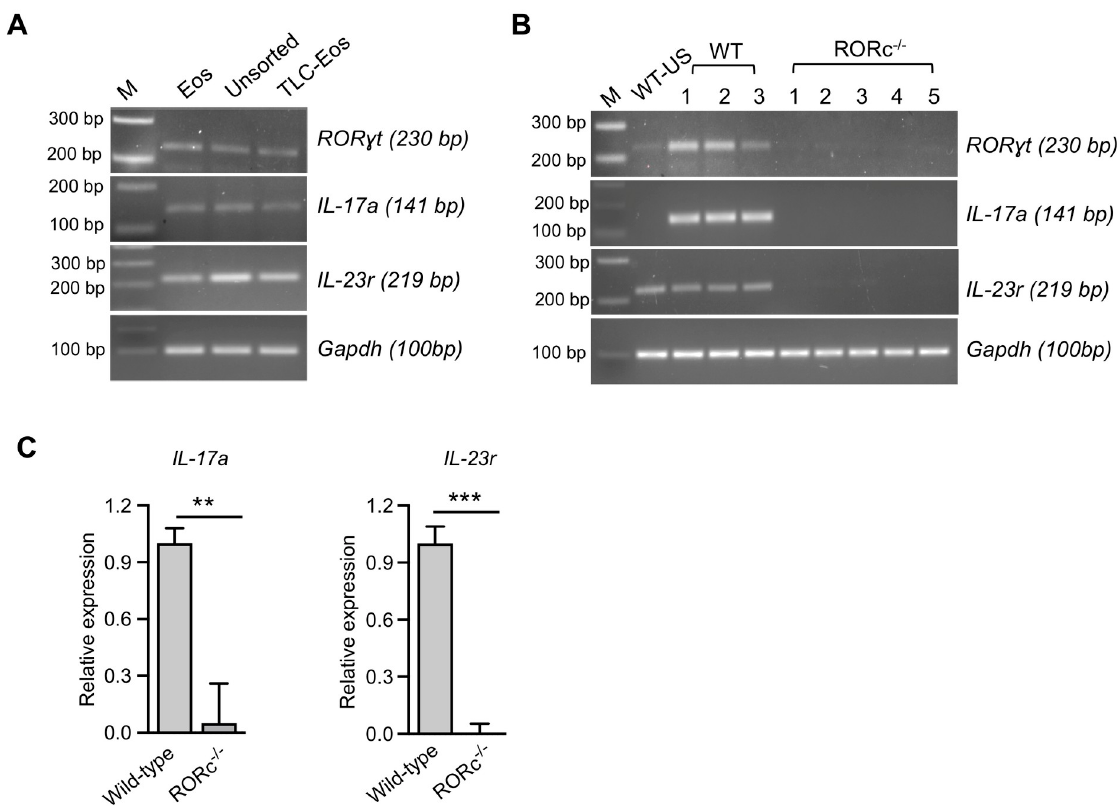
Fig 5. ROR γ t, IL-17 and IL-23r gene expression in lung eosinophils from wild-type and RORc -/- mice with allergic aspergillosis. (A) Allergic aspergillosis was induced in C57BL/6 mice as in Fig 1A, following which lungs were harvested and single cell preparations were made. The total lung cells (TLC) were separated into two populations by flow-sorting: eosinophils (Eos) and the rest of the lung cells (TLC— Eos). Unsorted TLC from a lung of allergic mice was also collected. ROR γ t , IL-17a , IL-23r mRNA in the three cell populations was analyzed by RT-PCR. Gapdh served as a loading control. These results are representative of two independent experiments with n = 7–8 mice per experiment. The indicated DNA ladders served as base pair (bp) markers (M). (B) Allergic aspergillosis was induced in wild-type (WT, n = 3) and RORc -/- mice (n = 5), following which mRNA was isolated from harvested lungs and analyzed by RT-PCR for ROR γ t , IL-17a , IL-23r and Gapdh . DNA markers are as in Fig 5A. Wild-type unstimulated (WT-US) refers to results obtained using lung mRNA from a na ï ve (non- allergic) mouse. The remaining lanes show results from mRNA isolated from the lungs of individual WT and RORc -/- mice with allergic aspergillosis. (C) Real time quantitative RT-PCR for IL-17a and IL-23r was performed using mRNA isolated from lung cells obtained from wild-type and RORc -/- mice with allergic aspergillosis. Results are expressed as means + SEM (n = 4 mice/group) of relative gene expression compared with the internal control, Gapdh . �� p = 0 . 006; ��� p = 0 . 001)